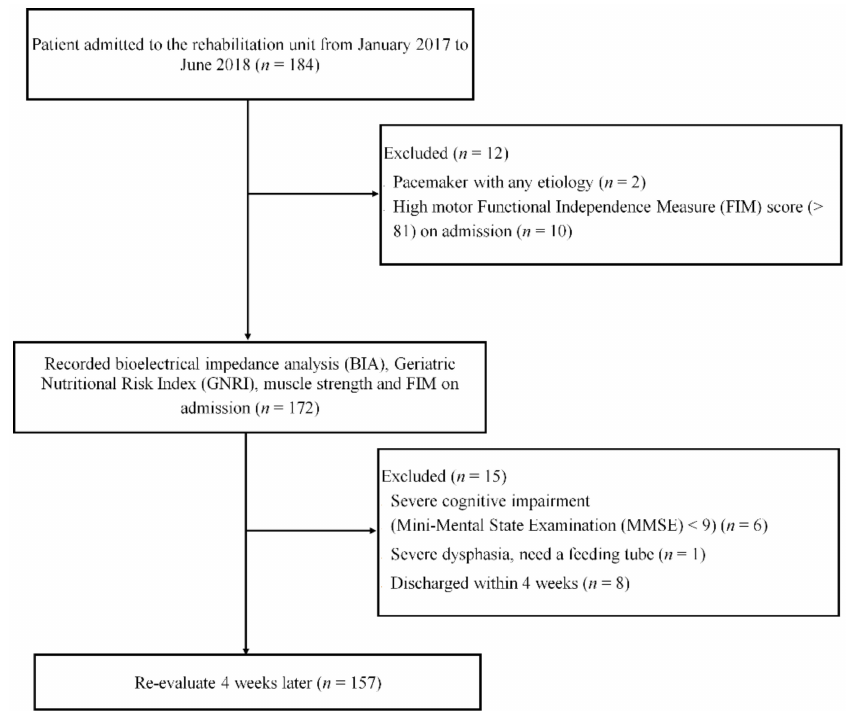
Figure 1. Flowchart showing patients included and excluded from the study. Initially 184 patients were enrolled, and finally 157 were